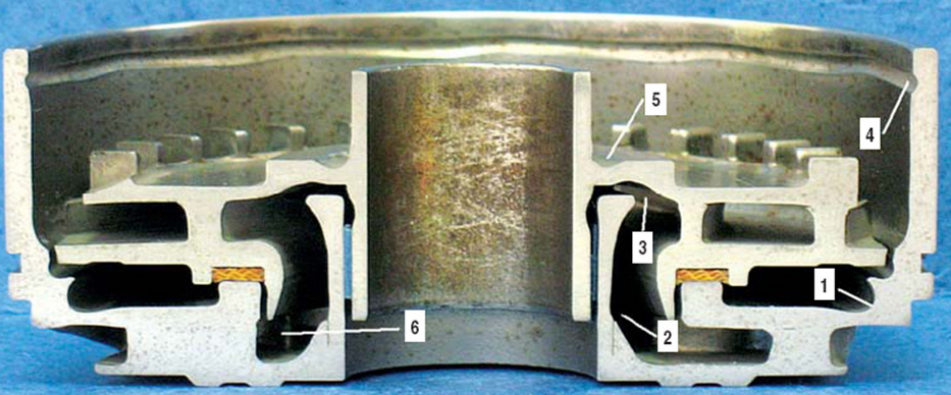
Figure 2. Hydroabrasive wear of the VNN5A-100 stage after the tests.